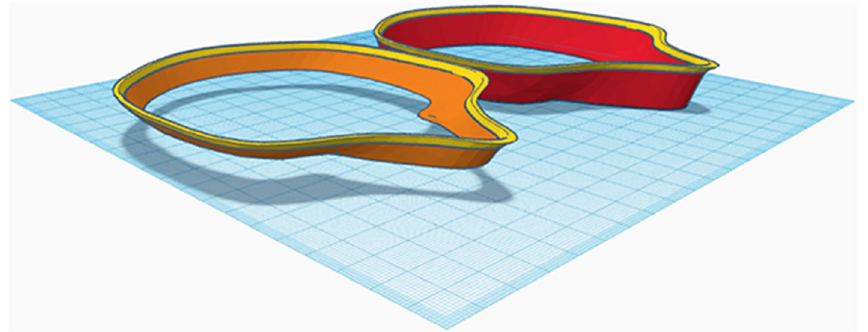
Figure 6. For demonstration purposes, the original slice has been cut into a 2 mm proximal (yellow) and a 6 mm ventral (orange) part; the ventral part has been stretched ventrally (red) and aligned with the unstretched proximal part (yellow) prior to grouping.